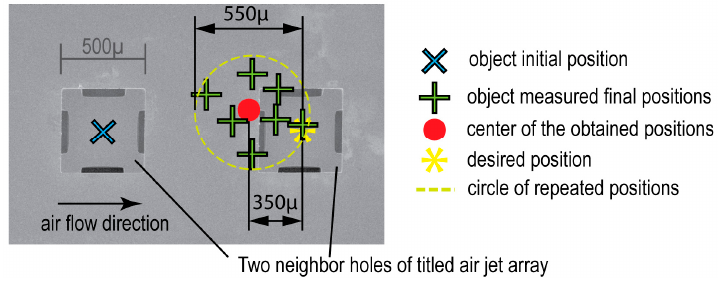
Figure 19. Repeatability and accuracy calculation, based on the difference measurement between the desired and the obtained positions of the µobject.